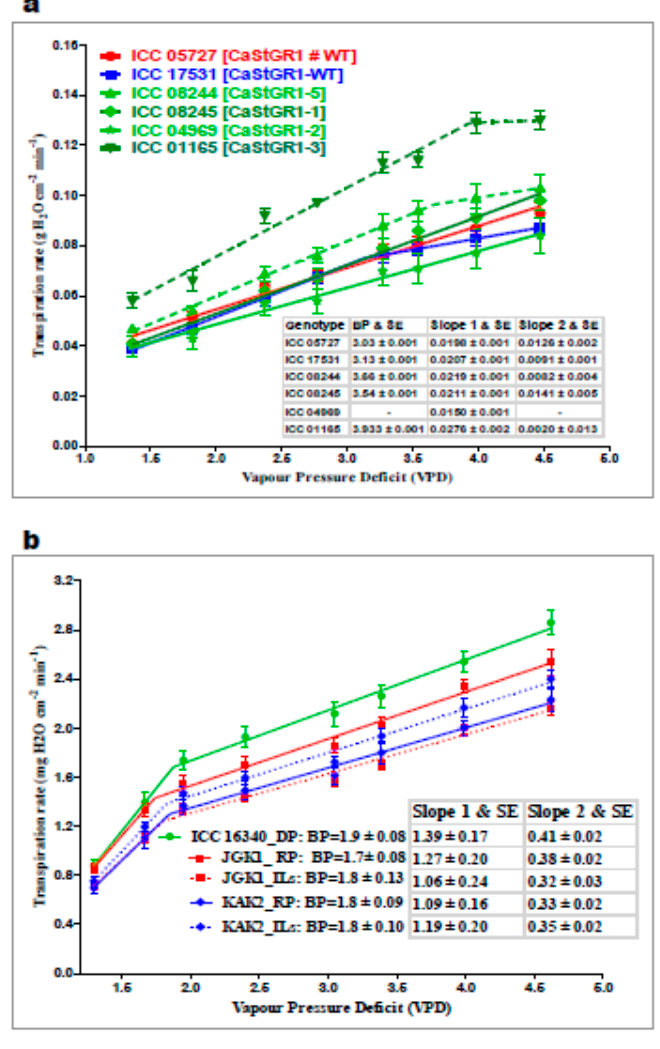
Figure 5. ( a ) Transpiration rates (TR) of six selected chickpea genotypes di ff ered in deletion of CaStGR1gene segments [ICC 05727-CaStGR-1-#Wild type (round with solid red line); ICC 17531-CaStGR-1-Wild type (square with solid pink line); ICC 08244-CaStGR-1-5 (upward triangle with solid green line); ICC 08245-CaStGR-1-1 (diamond with solid blue line), ICC 04969-CaStGR-1-2 (star with solid orange line) and ICC 01165-CaStGR-1-3 (downward triangle with solid pink line)] in response to increasing VPD. During detached leaf green assay, ICC 05727-CaStGR-1-#Wild type showed yellow colour in all leaflets fully. By contrast, ICC 17531-CaStGR-1-Wild type showed semi-green colour leaflets. Genotypes with CaStGR1-1 (ICC 08245), CaStGR1-2 (ICC 04969), CaStGR1-3 (ICC 01165), and CaStGR11-5 (ICC 08244) showed completely green colour in all the leaflet during detached leaf green assay. TRs were measured on well-watered plants grown in the glasshouse, which were temporarily transferred to a growth chamber with control over temperature and relative humidity. There, plants were exposed to increasing VPD, set by modifying temperature and humidity. TR data are the mean of five replicate plants, computed hourly at each of the eight VPD levels. Data were used to draw a segmental or a single linear regression for all tested genotypes. Each data points represents the means ( ± SE) of five replicates per genotype. The slopes and breakpoint (BP) of regressions are displayed in the figures. ( b ) Transpiration rates (TR) of stay green chickpea introgression lines (ILs) with di ff erent genetic background [stay green donor parent (DP) ICC 16,340 (square with solid green line); Recurrent parent (RP) JGK1 (square with solid red line); JGK1 background introgression lines JGK1-ILs (square with dashed red line); Recurrent parent (RP) KAK2 (diamond with solid blue line); KAK2 background introgression lines KAK2-ILs (diamond with dashed red line)] are response to increasing VPD. TRs were measured on well-watered plants